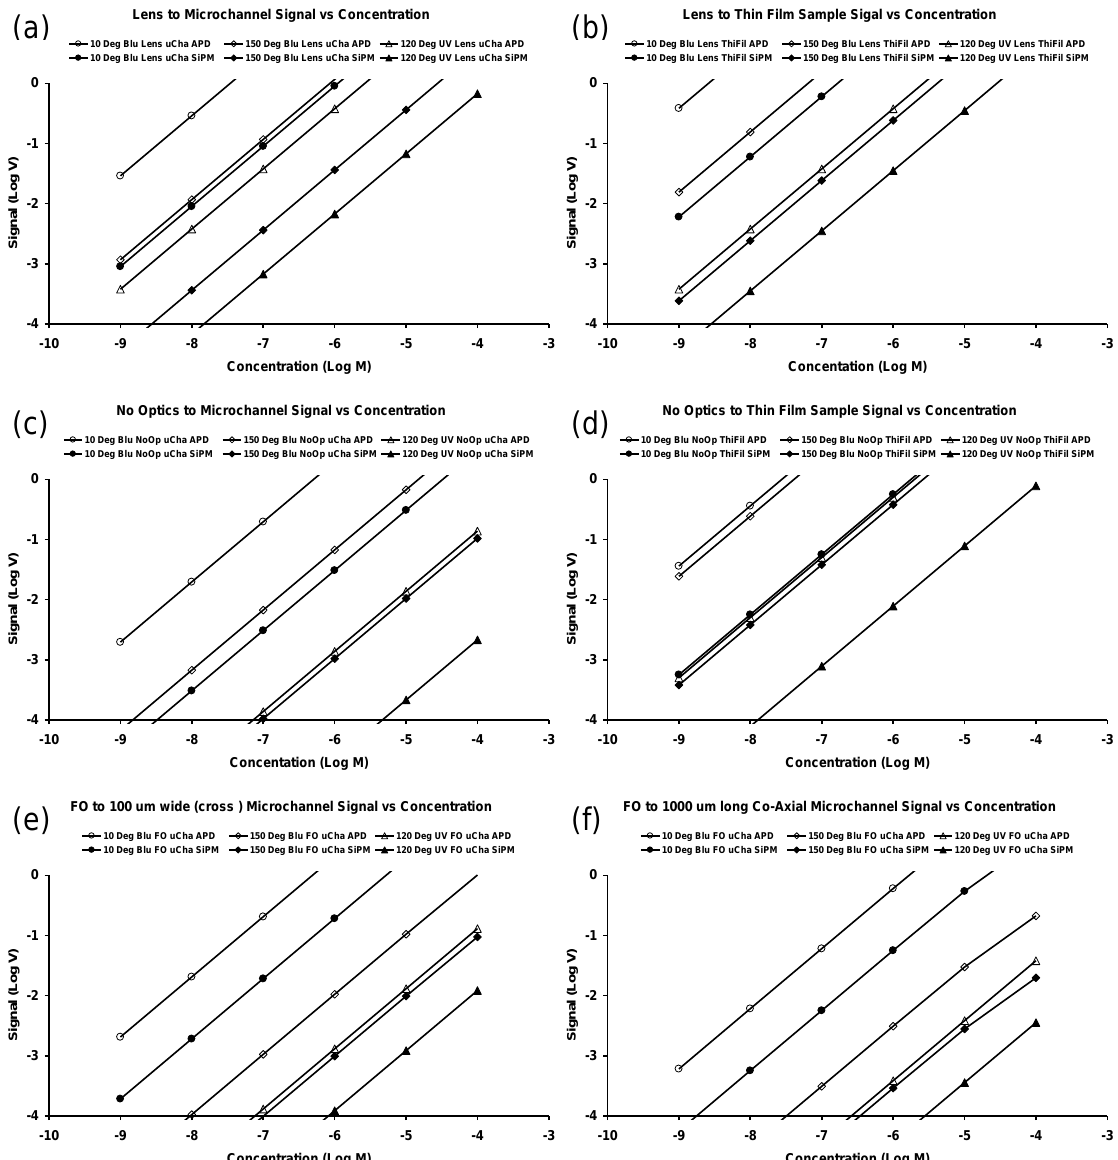
Figure 8. Computed calibration curves as a function of the molar concentration of fluorescein for several geometries, sources, optics and detectors: (a) lens (1.5 cm focal length and diameter) coupling to a 100 µm square microchannel, (b) lens (1.5 cm focal length and diameter) coupling orthogonal to a 100 µm thin film, (c) light from sources to 100 µm square microchannels and fluorescence to detectors without intervening optics and (d) light from sources to 100 µm thin films and fluorescence to detectors without intervening optics, (e) fiber optic (100 µm diameter ) coupled orthogonal (cross) to a 100 µm square microchannel, (f) fiber optic (100 µm diameter) coupled within (co-axial) a 1,000 µm length of a 100 µm square channel. The sources are blue LEDs with either 10 or 150 degree full emission angles or a UV LED with a 120 degree full emission angle. A filter was employed and the transmission loss through the filter was calculated, as described in Section 2.7. The detectors are either an amplified photo diode (AmPD) or a Silicon photomultiplier (SiPM). The straight lines are drawn through the computed points in these